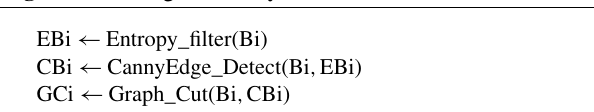
Algorithm 1 Bog Boundary